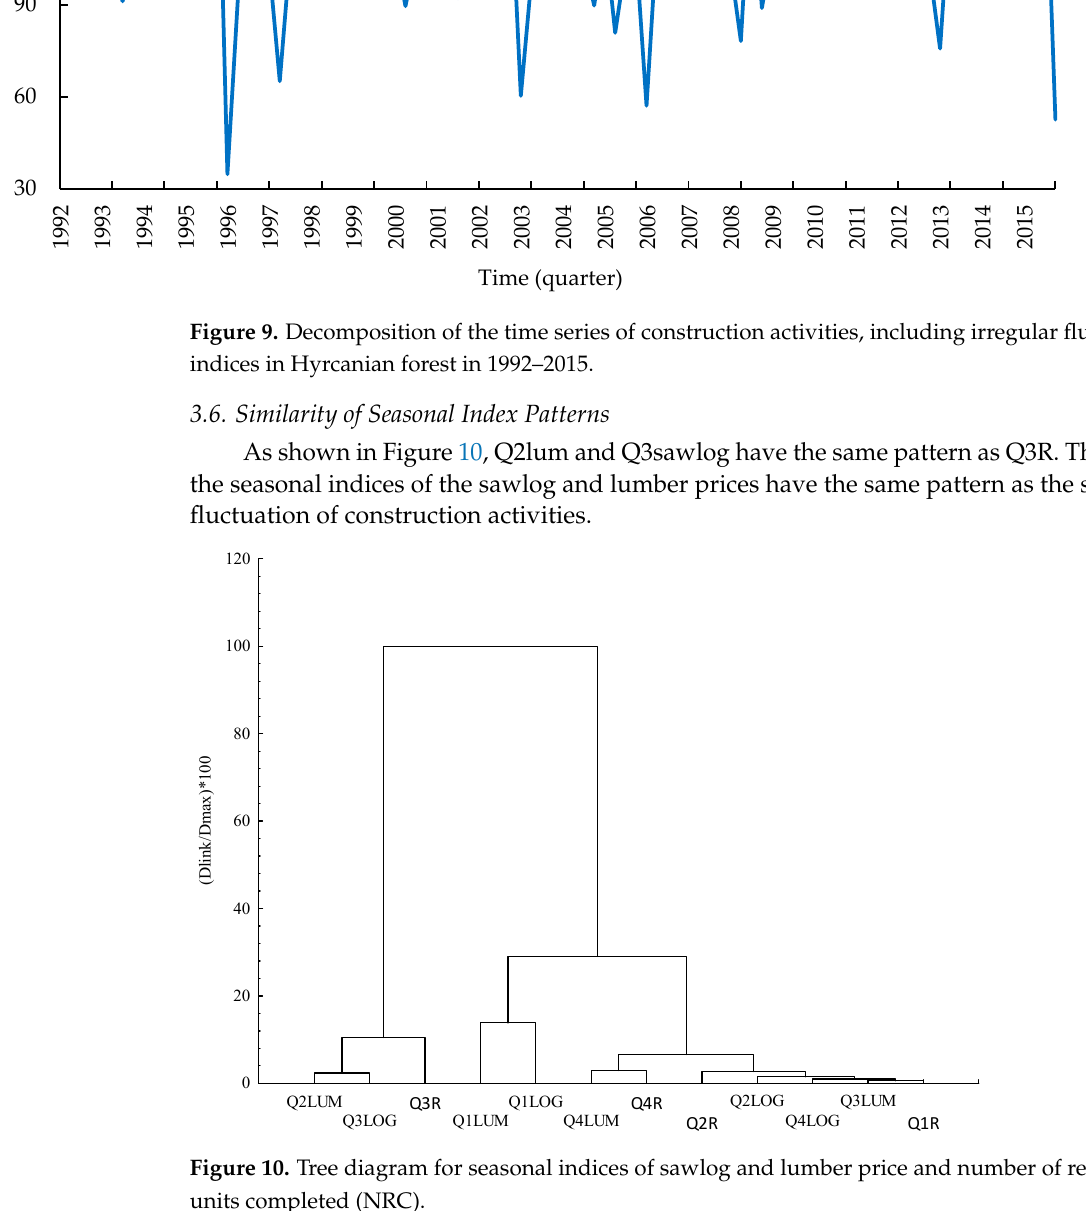
Figure 10. Tree diagram for seasonal indices of sawlog and lumber price and number of residential units completed (NRC).